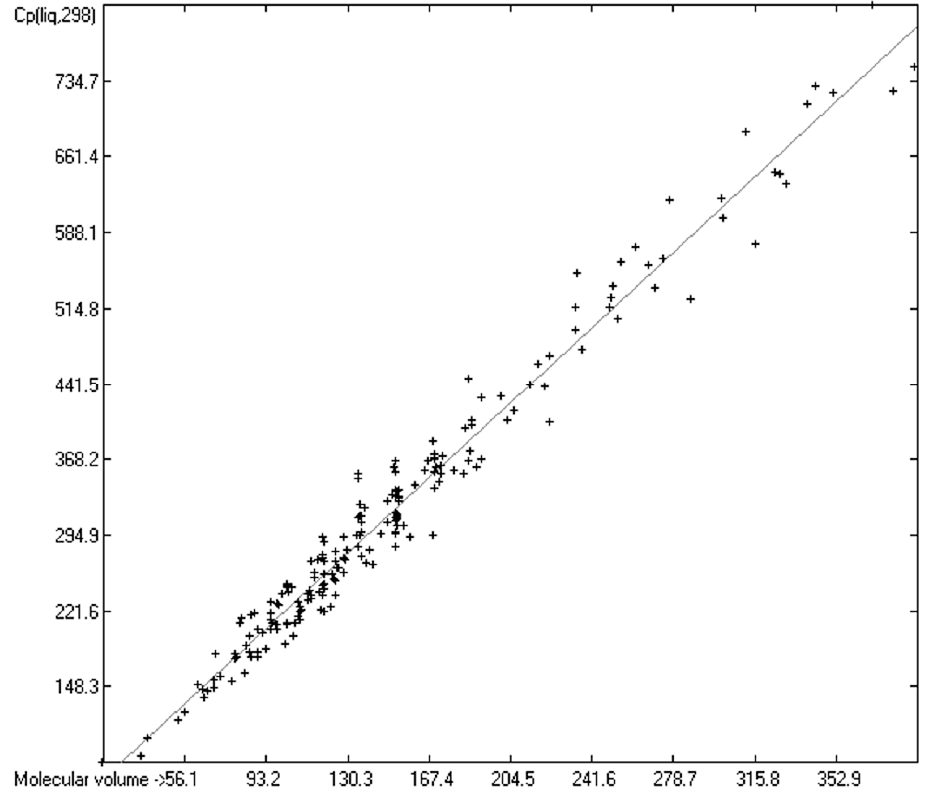
Figure 6. Correlation of molecular volumes with Cp(liq) at 298.15 K of mono- and polyols and –acids. (N = 201, R 2 = 0.9724, σ = 23.24 J/mol/K, MAPD = 6.11%, regression line: intercept = 20.9141, slope = 1.9676).